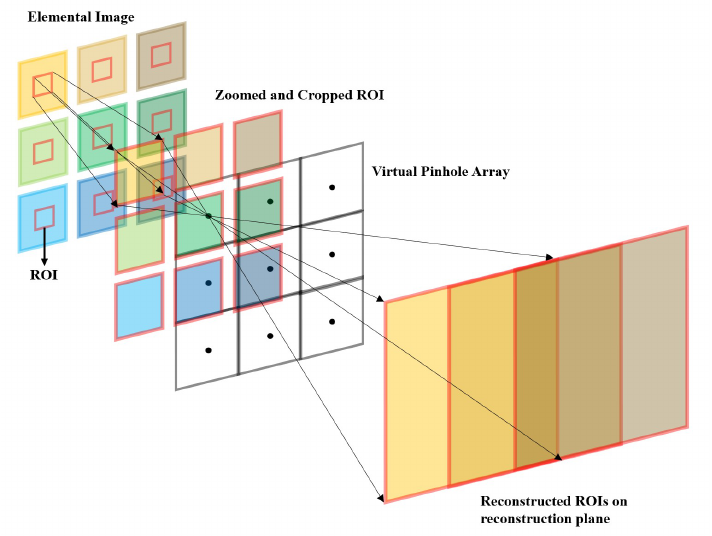
Figure 3. Procedure of our